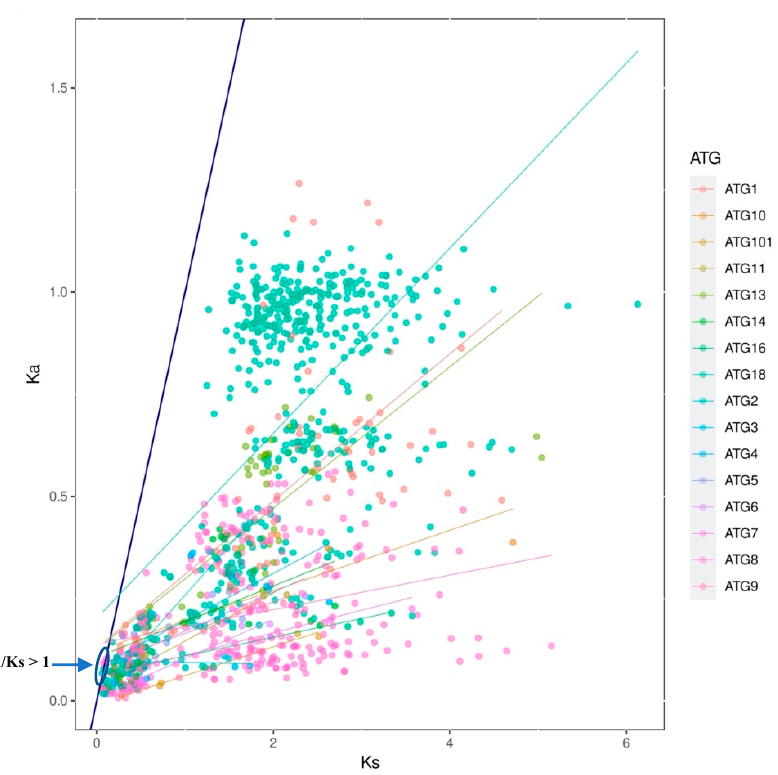
Figure 3. Ka/Ks ratios of 17 families of ATGs in A. thaliana, P. vulagris, G. max and M. truncatula . The distribution of Ka and Ks values are obtained using TBtools. The dark blue line divides the Ka/Ks ratios lower and higher than 1 (dots in the highlighted area Ka/Ks > 1).